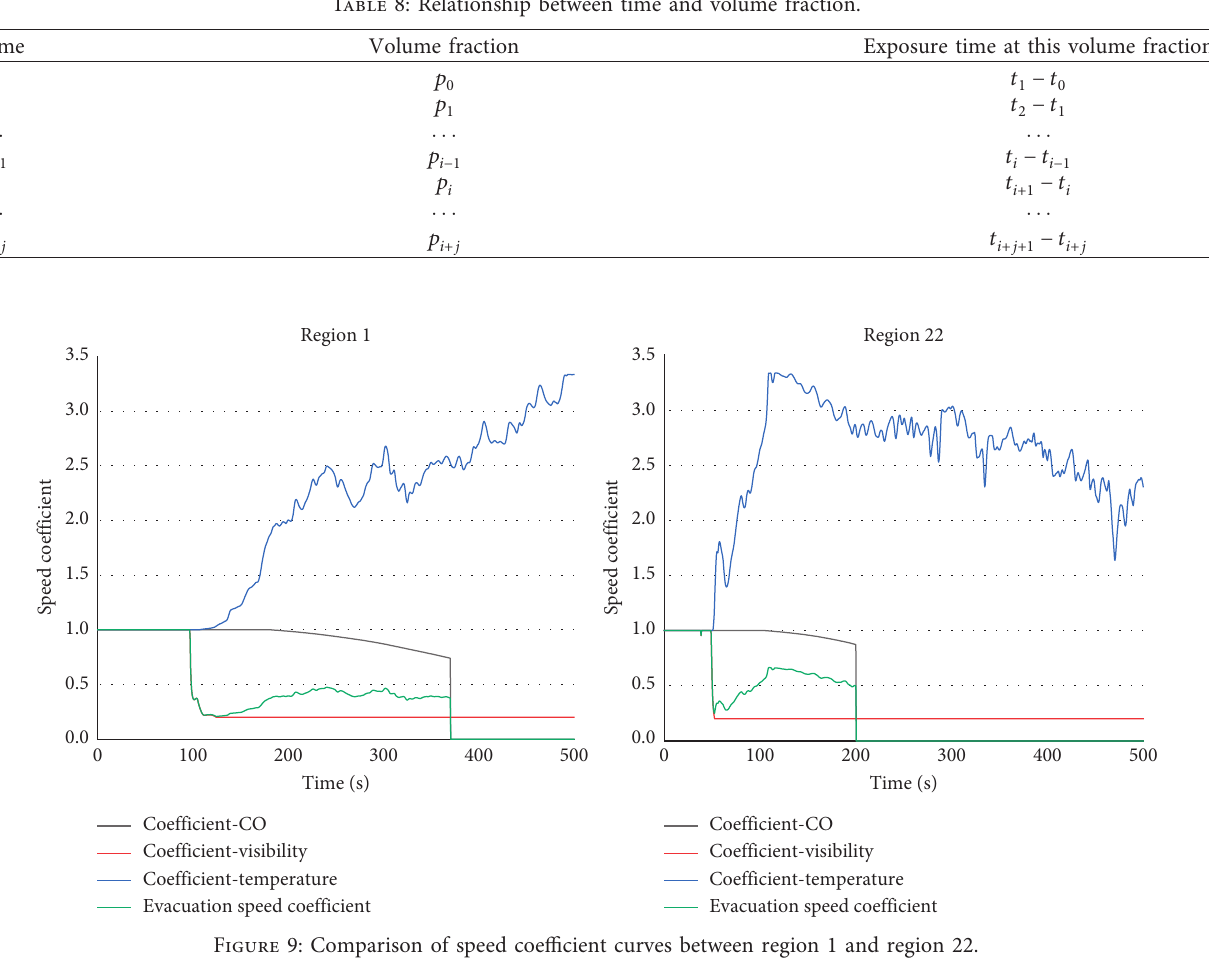
Table 8: Relationship between time and volume fraction.